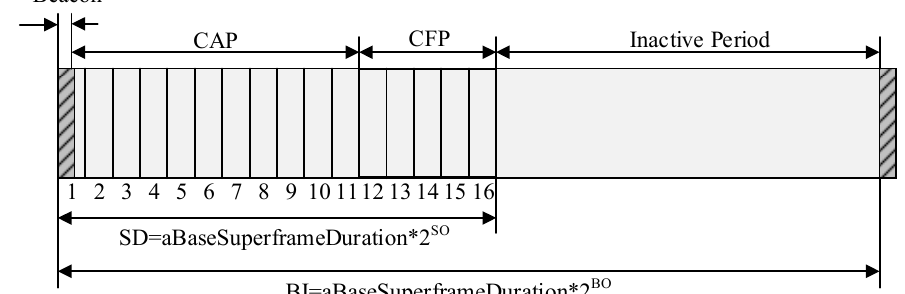
Figure 1. The superframe structure in the IEEE 802.15.4 standard.